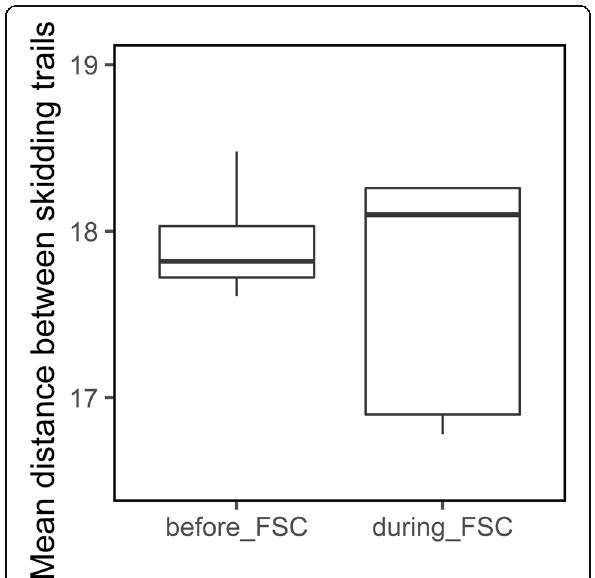
Fig. 6 Mean distance between skidding trails on clearcuts before FSC certification ( n = 5) and during valid FSC certification ( n = 5)